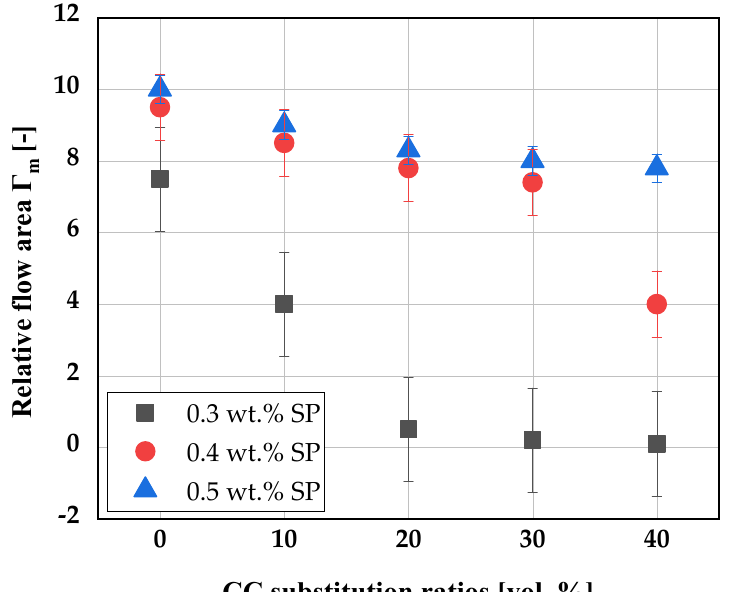
Figure 3. Influence of CC on the Г m of SC-P.